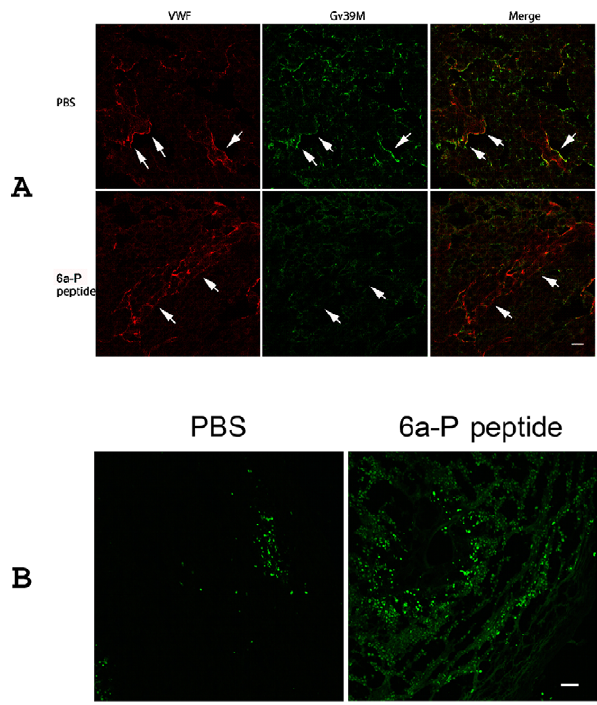
Figure 5. Tumor vessel activity is inhibited by 6a-P peptide. To verify the inhibition of complex of VEGF with KDR, we used the Gv39M monoclonal antibody to recognize VEGF/KDR complex in both peptide and PBS treated xenograft animal sections. Immunohistochemistry result shows that VEGF/KDR complexes are colocalized with vessels (VWF staining) on PBS treated tumor (A; up panel). However, the staining signal is decreased after peptide treatment (A; lower panel). The TUNEL assay shows more apoptotic cells in treated than untreated groups on tumor (B). (Bar, 100 m m) imaged by confocal-microscopy (model DM IRE2; Leica). DAPI or Hoechst33258 counterstaining of nuclei are shown in blue.